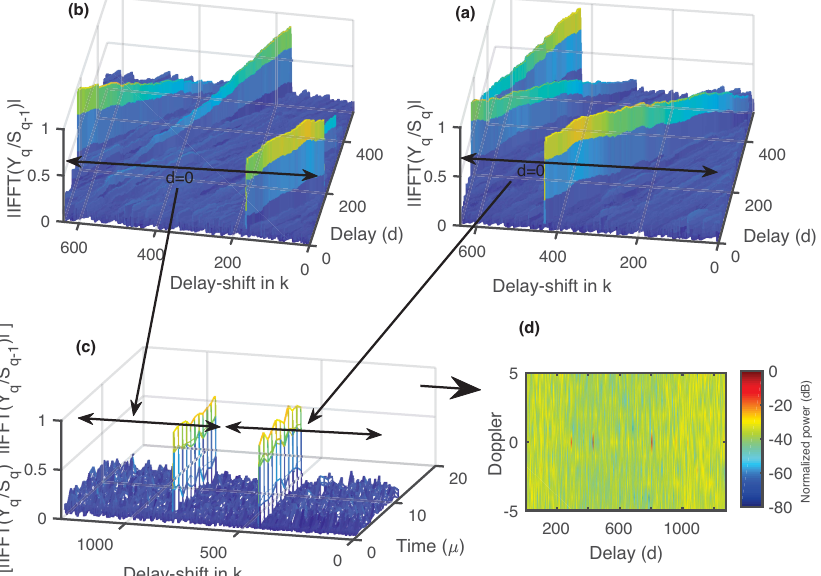
Figure 2. Explanation of the proposed method when range extension is up to two OFDM symbols. ( a , b ) Steps 1–4 of the proposed method provide two matrices. ( c ) Delay–zero rows of the matrices in ( a , b ) are concatenated according to the step 5. ( d ) Range/speed plot is completed using M –point FFT operation over time domain.